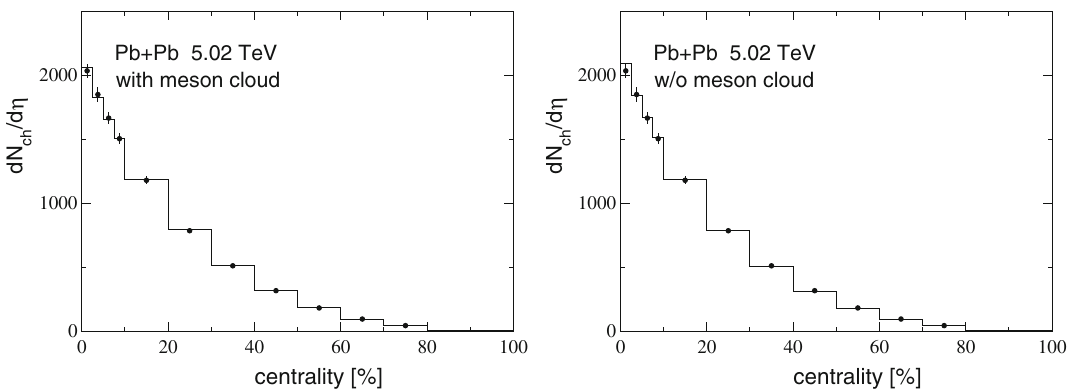
√ s = 5 . 02 TeV. Left: MCG simulation for the scenario with